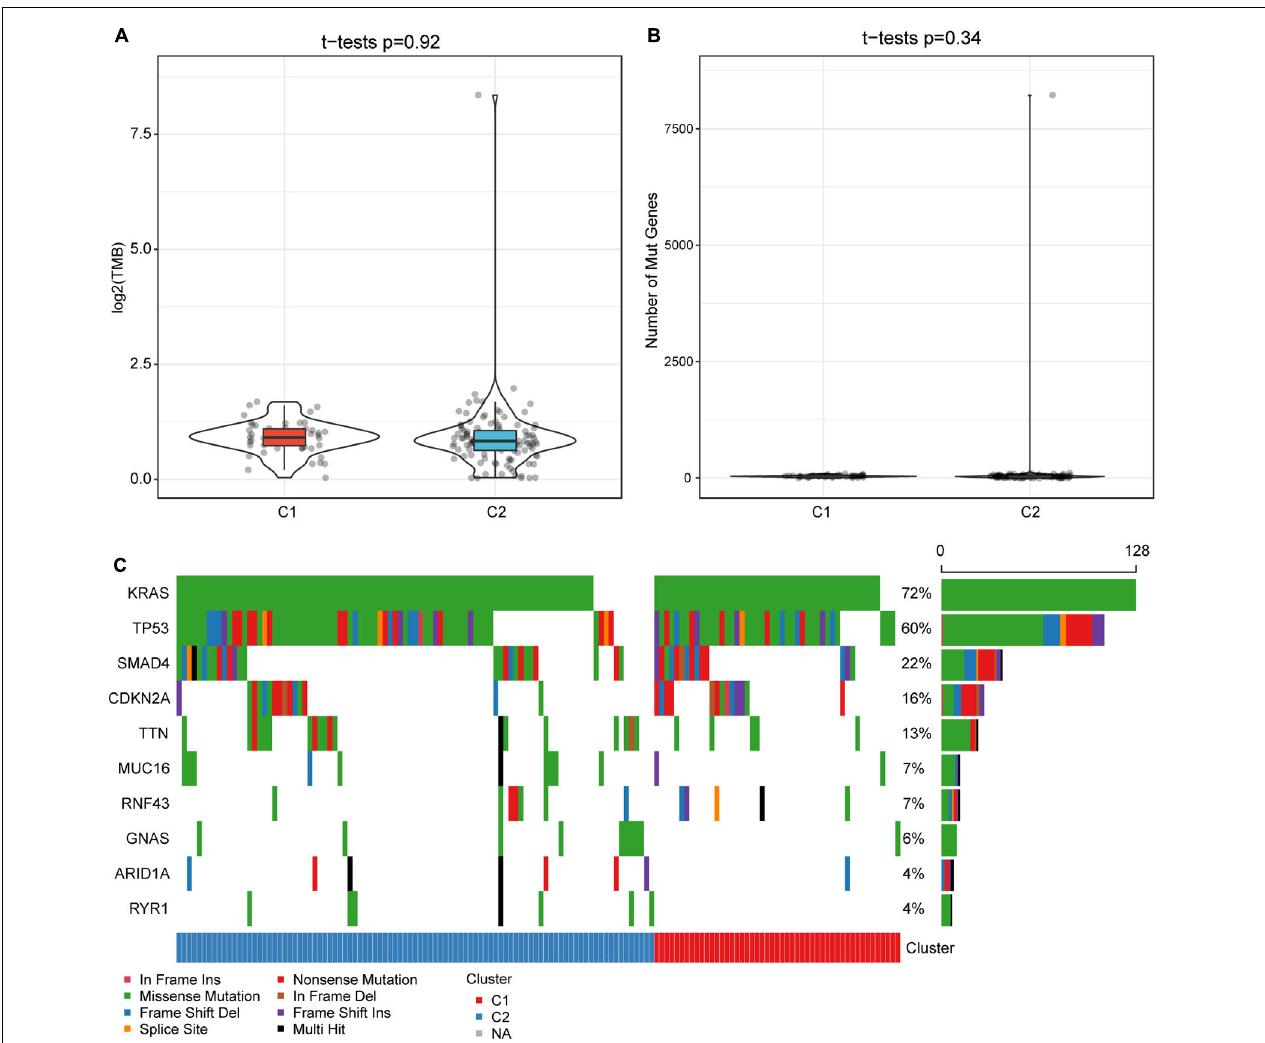
FIGURE 3 | Tumor mutation burden and gene mutation characteristics among molecular subtypes. (A) Differences in the distribution of TMB between subtypes. (B) The distribution difference of the number of gene mutations between subtypes. (C) Mutation characteristics of top 10 genes in two subtype samples. The rank sum test is used to determine the p